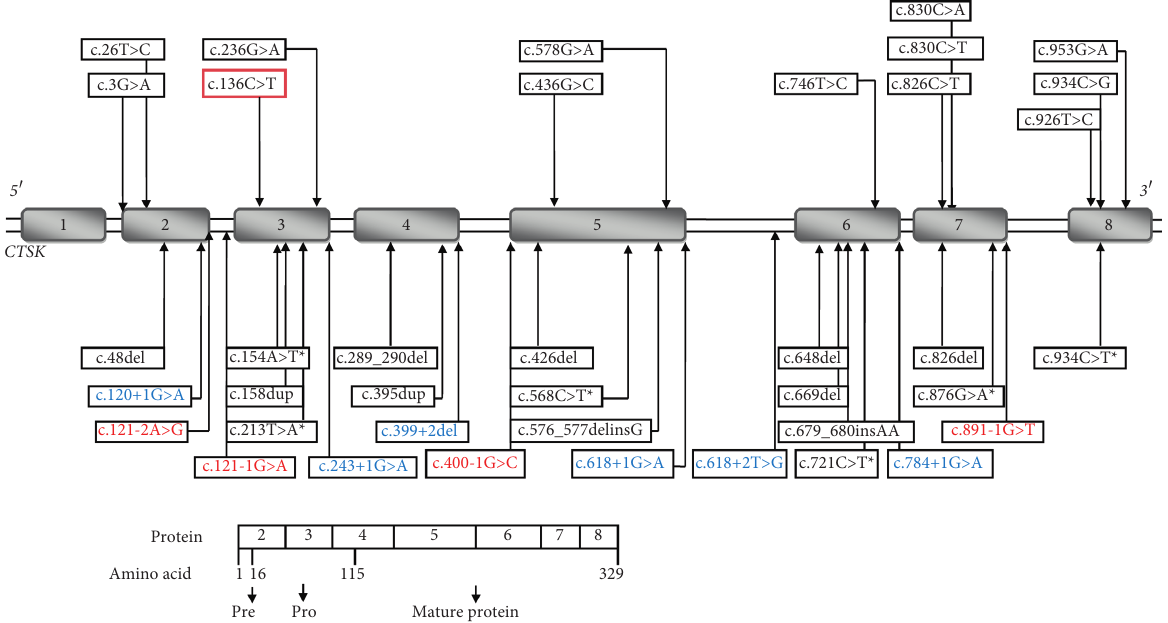
Figure 4: Pathogenic and likely pathogenic variants reported in CTSK gene leading to pycnodysostosis and sometimes osteopetrosis. The schematic representation of genomic structure of CTSK gene showing a total of 39 reported pathogenic (7) and likely pathogenic (32) gene variants for pycnodysostosis in 8 exons in which exon1 is non-coding (shown in shaded boxes). The top half of the figure show distribution of 13 missense variants in upper panel, 10 frameshift, 6 nonsense (with ∗ sign), 6 and 4 splice donor (blue colored) and splice acceptor (red colored) variants respectively in lower panel. The bottom half of the figure shows protein having 15 residues pre-region, 99 residues pro- region and 215 amino acid long mature proteins. The index child in present report showed variant c.136C > T (highlighted in red box) associated with